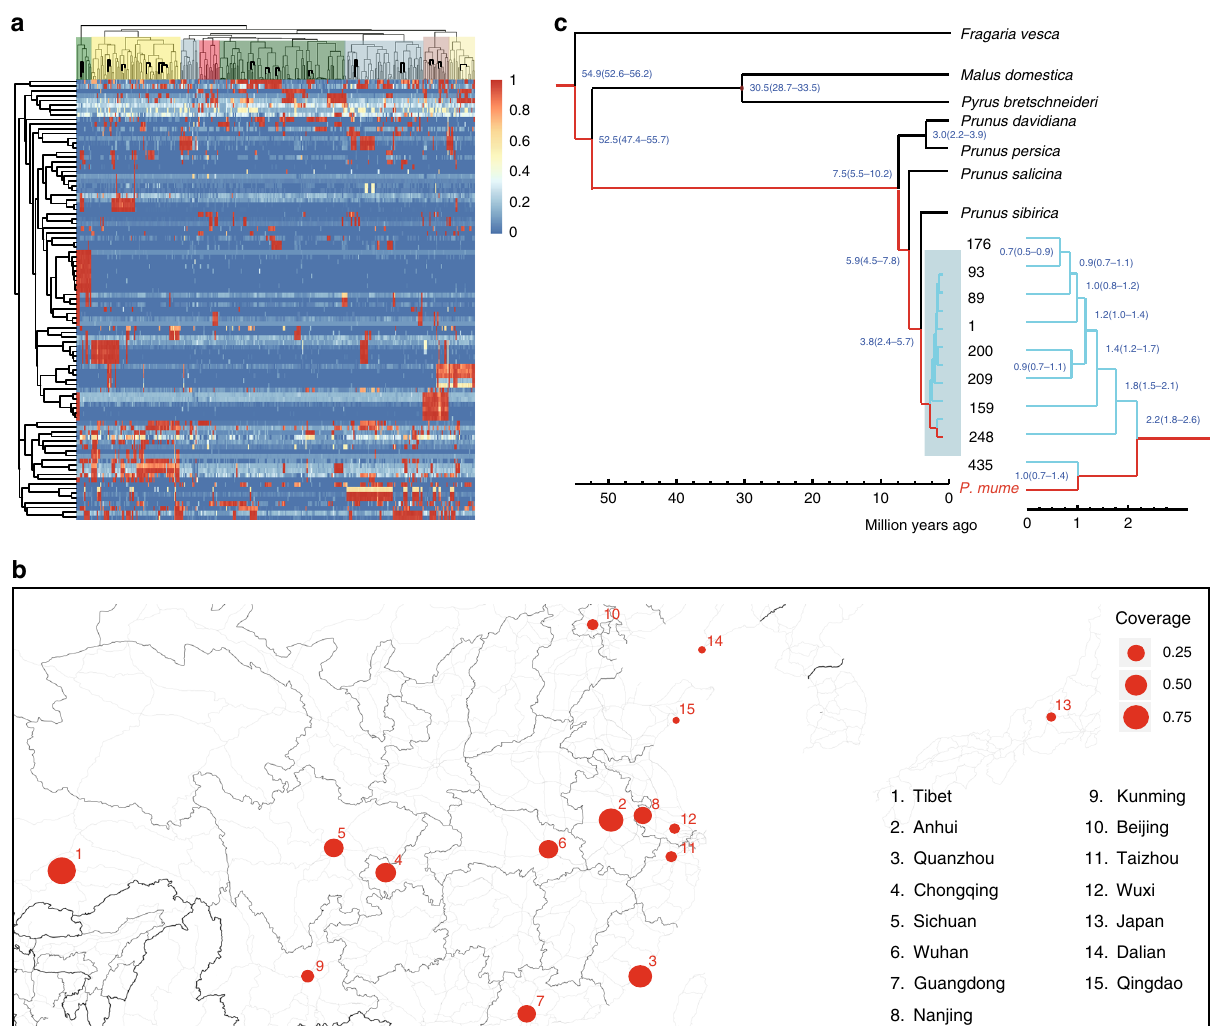
Fig. 3 Evolution of P . mume and Prunus . a Clustering of 351 re-sequencing samples using coverage of PAVs in mei genomes. Coverage ratio in each box was calculated by mapping reads from each sample to each PAV. b A PAV identi fi ed in S176 shows divergent coverage across samples in subpopulation P11. Map image was generated from http://maps.stamen.com/#toner/12/37.7706/-122.3782, using R/ggmap package. c Reconstruction of the evolutionary history of Prunus and P . mume